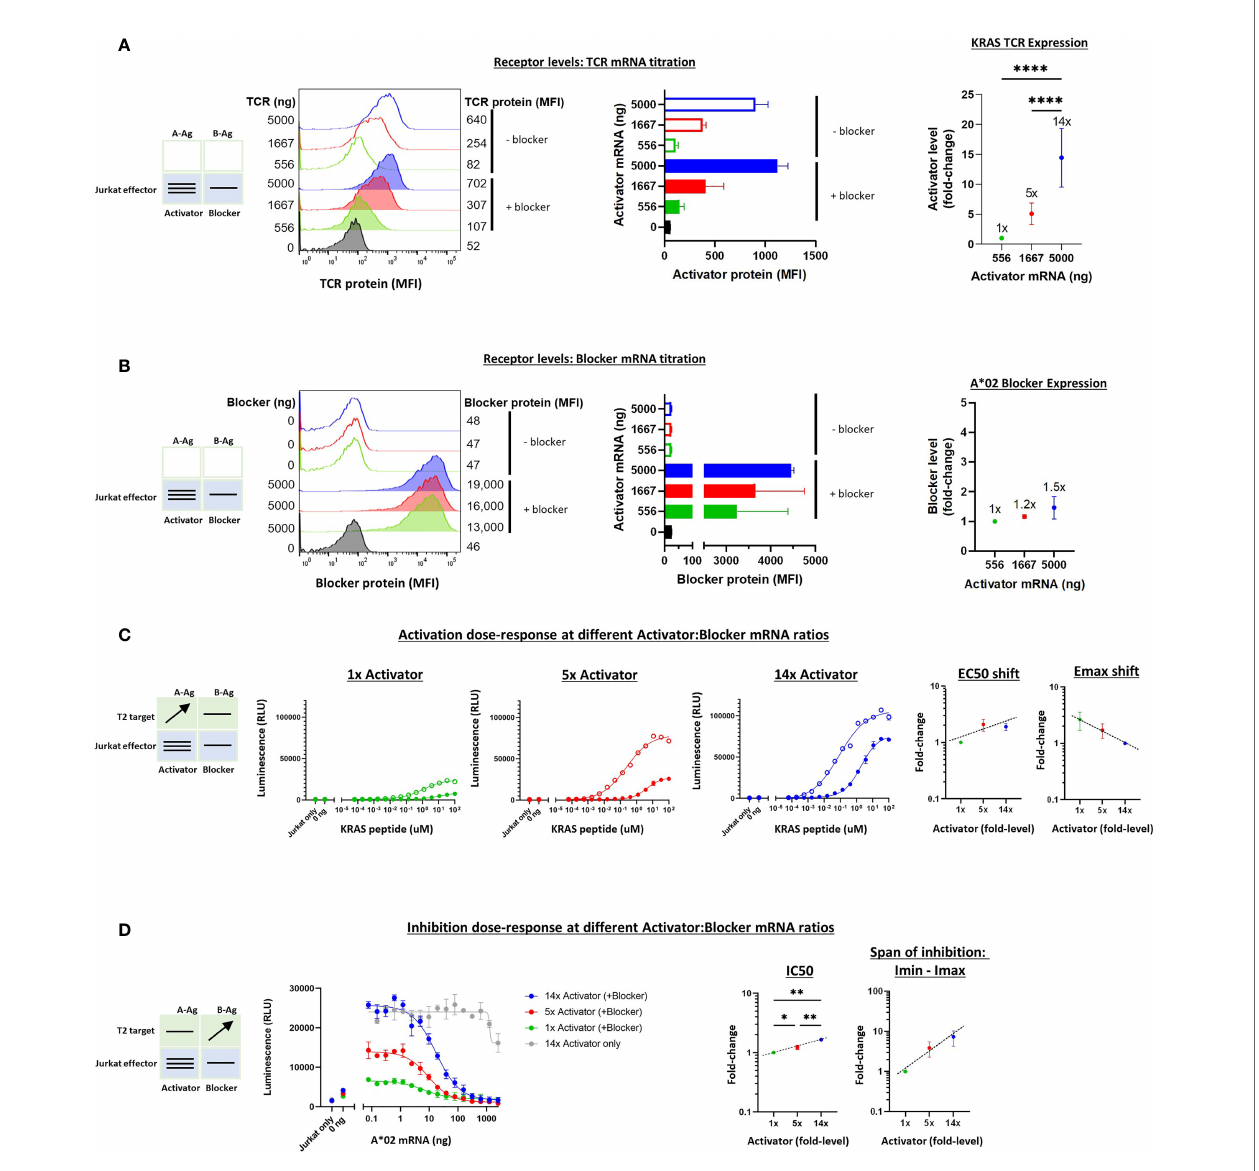
FIGURE 6 | Altering the ratio of KRAS TCR activator to A*02 blocker in effector cells. A*02 blocker mRNA was fi xed at 5000 ng and KRAS TCR mRNA was varied at 0, 556, 1667 and 5000 ng as indicated. (A) TCR expression was measured by staining with labeled muTCR b mAb (see Methods ). (B) Surface expression of blocker at different mRNA amounts of CAR activator; blocker protein level was minimally affected by varying activator level. Blocker was stained with A*02 pMHC tetramer (see Methods ). Fold-changes shown on graphs (i.e. 1x, 2x, 3.5x) are based on surface protein estimates, not mRNA amount. MFI, geometric mean fl uorescence intensity. (C) Activation response to varied ratios of KRAS TCR to A*02 blocker. Open circles = TCR only, fi lled circles = TCR + blocker. Activation dose-response curves are shown for each ratio of TCR to blocker tested, titrating A-Ag (KRAS peptide) with constant B-Ag (200 ng A*02 mRNA, ~250,000 molecules/cell). Shifting of EC50 and Emax with blocker present is shown for each activator amount. (D) Inhibition response to varied KRAS TCR to A*02 blocker ratios. A-Ag was kept constant (20 nM KRAS peptide) while B-Ag was varied (A*02 mRNA). Dashed lines are meant to convey trends and are not fi t mathematically. *p<0.05, **p < 0.01, ***p < 0.001, ****p < 0.0001, n =